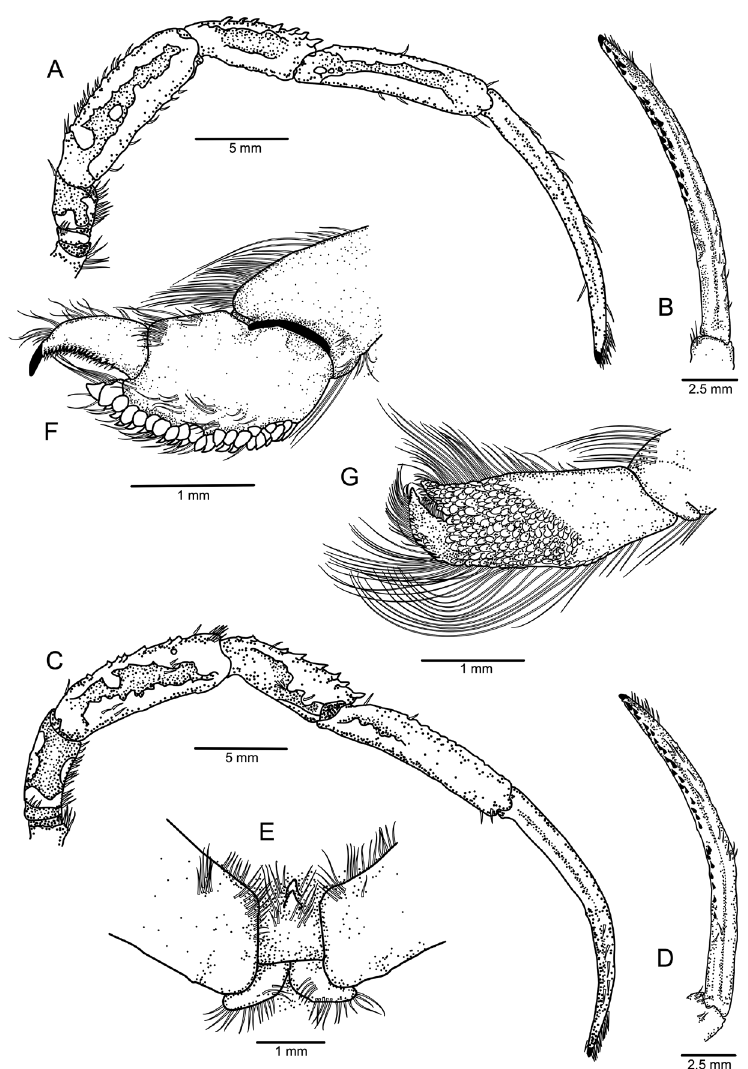
Figure 5. Paragiopagurus atkinsonae sp. n., South Africa, West Coast, male holotype 7.0 mm, WCDSS2016 (USNM 1292083). A pereopod 2, lateral view B dactyl of same, mesial view C pereopod 3, lateral view D dactyl of same mesial view E sternite XII and basal portion of coxae of pereopods 3, ventral view F propodus and dactyl of pereopod 4, lateral view G propodus and dactyl of pereopod 5, lateral